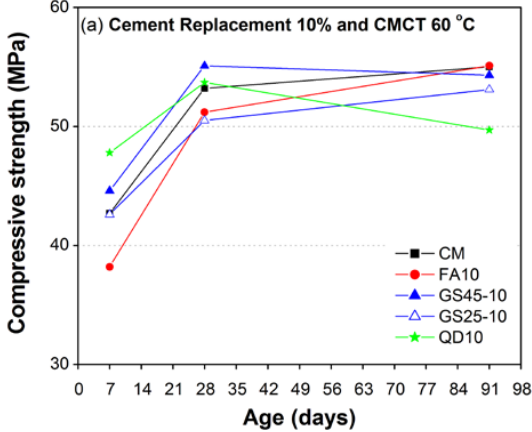
Figure 8. Cont. Figure 8. Cont.